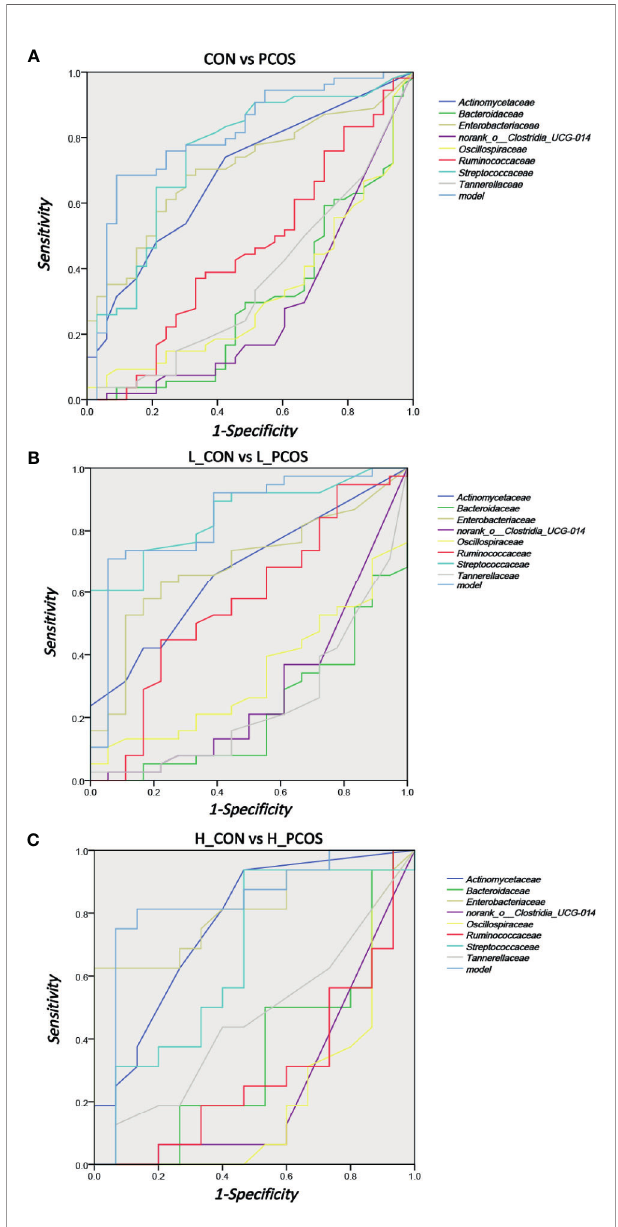
FIGURE 5 | ROC analysis for identifying disease status and subtypes by gut microbiota characteristics. (A) ROC analyses of 8 different gut microbiotas and the model were used to evaluate the ability of distinguishing PCOS. (B, C) ROC analysis of eight different gut microbiotas and the model were used to evaluate the ability of distinguishing L_CON and L_PCOS,H_CON and